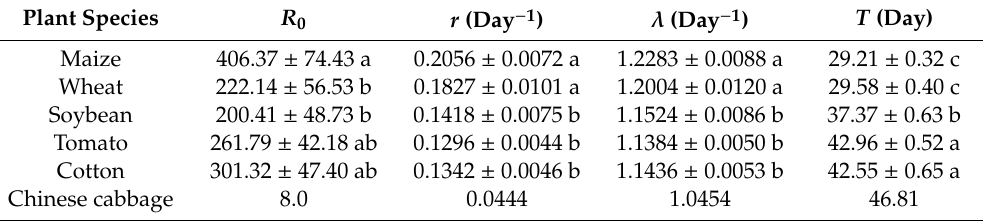
Table 3. Population parameters of S. frugiperda fed on six plant species.